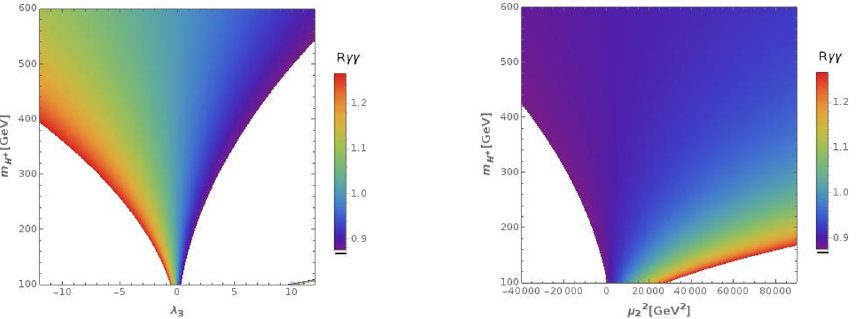
) plane (right). Only µ , µ 2 H ± 2